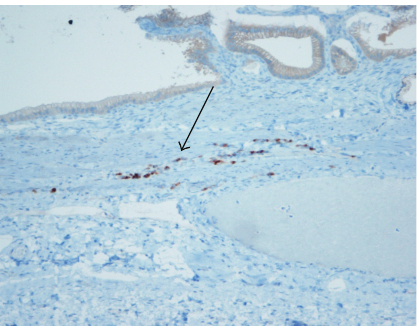
Figure 2: Estrogen positive cells in gallbladder wall on immunohis- tochemical